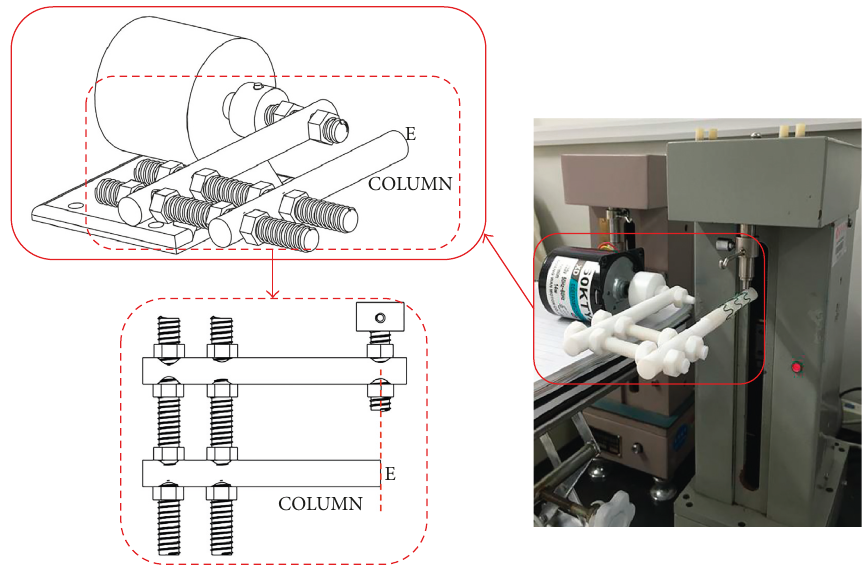
Figure 2: Device to mount stent graft for the bending and spring-back force tests.